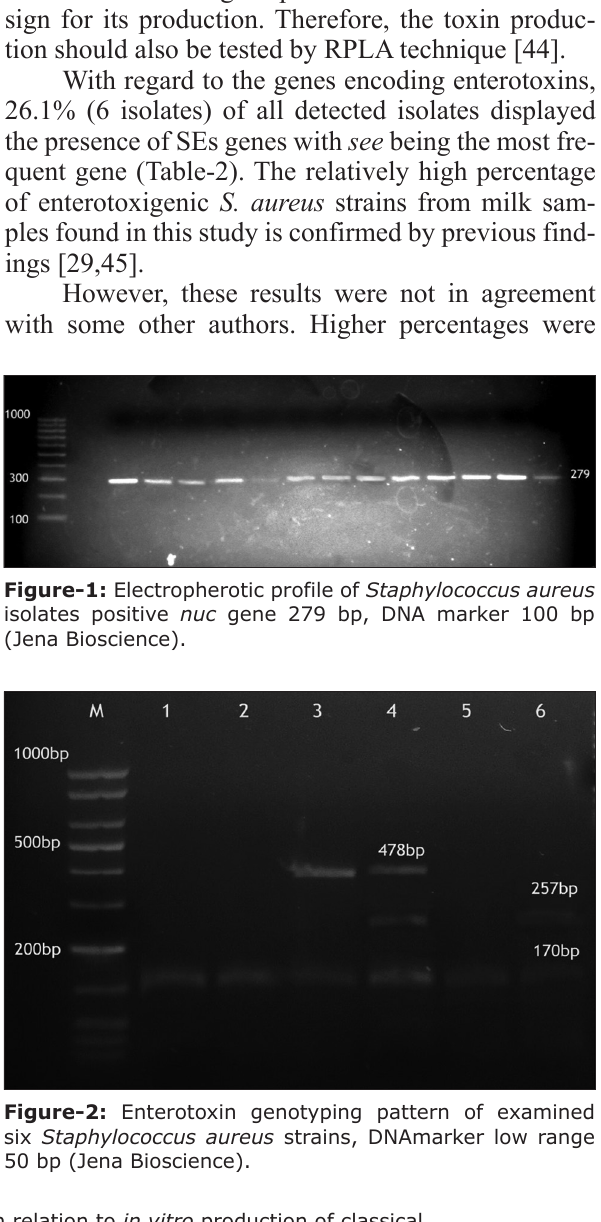
Table-2: Enterotoxins genotypic profile of S. aureus isolates in relation to in vitro production of classical enterotoxins (SEA, SEB, SEC and SED), as detected by the SET-RPLA. Isolate No.